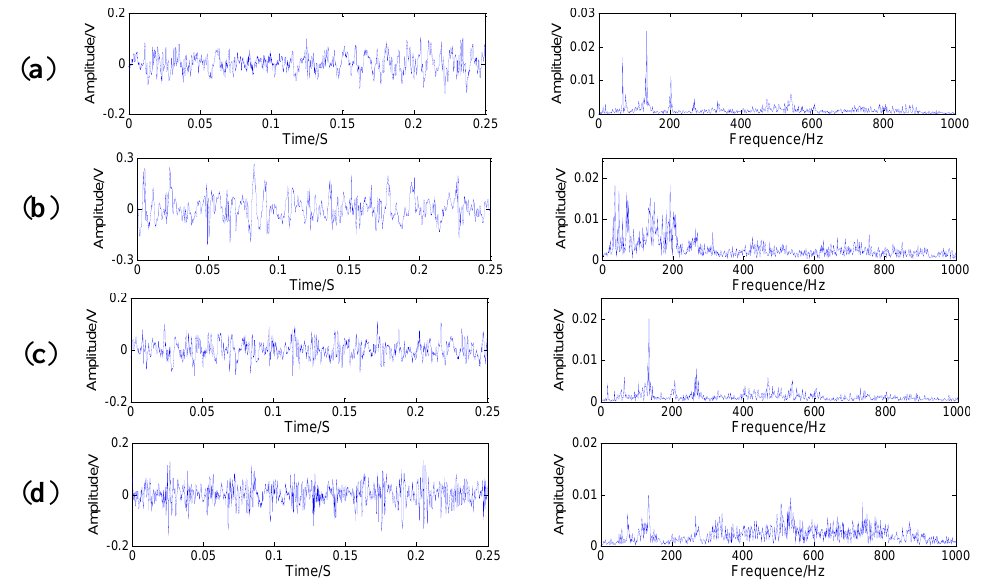
Figure 7. Original time waveforms and their corresponding spectrums of bevel gears in four conditions: ( a ) normal state; ( b ) worn tooth; ( c ) broken tooth; ( d ) missing teeth.